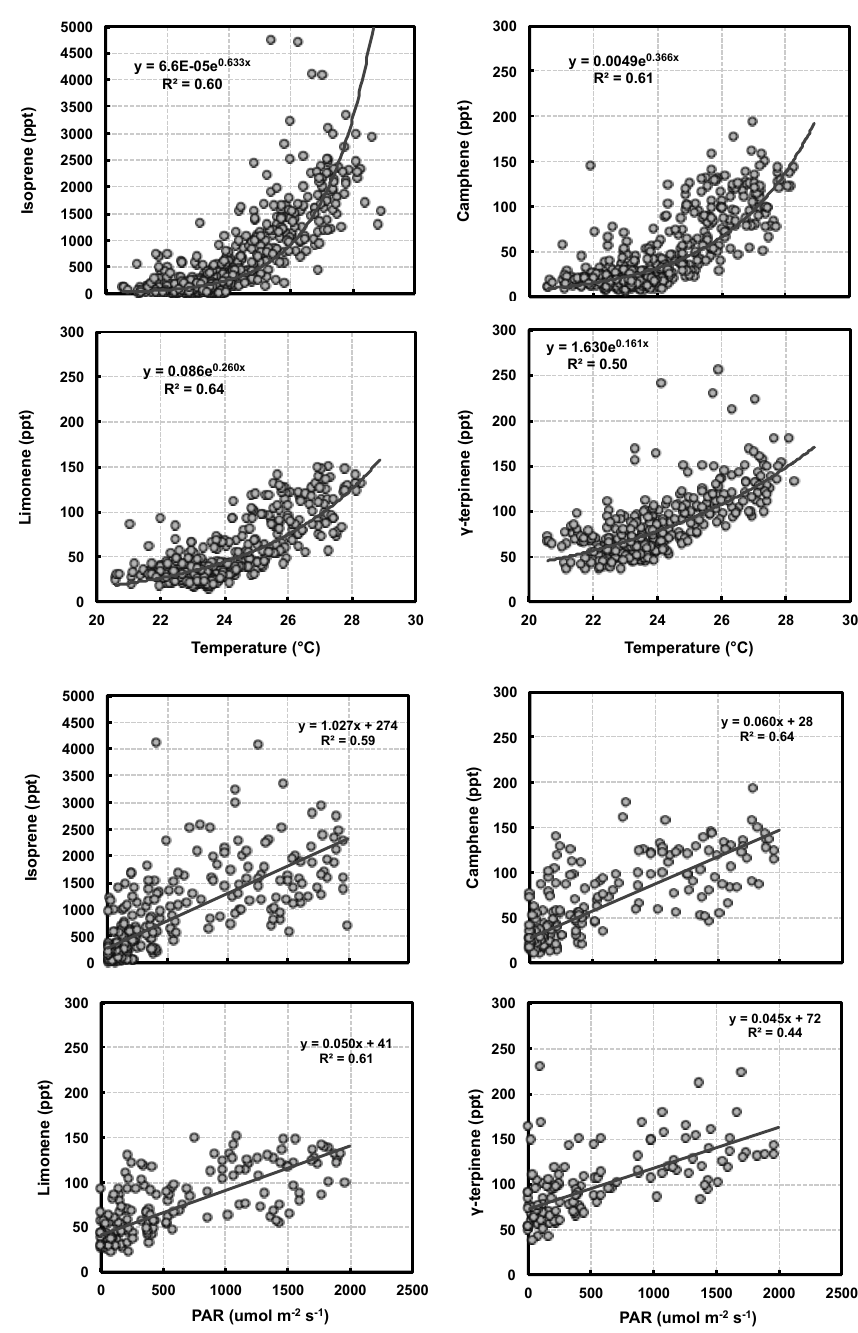
Fig. 4. Plots to show the correlations between isoprene, limonene, camphene and γ -terpinene vs. ambient air temperature and vs. PAR. a more moderate dependence upon both factors. Notably, the γ -terpinene mixing ratio remained significantly elevated during the late afternoon/evening, well after PAR and tem- perature had started to decrease, and remained above 80 ppt (on average) for 1–2 h after PAR had reached zero (Fig. 3). Since γ -terpinene is one of the shorter-lived monoterpenes (typical lifetime ∼ 45 min, Atkinson and Arey, 2003), persis-